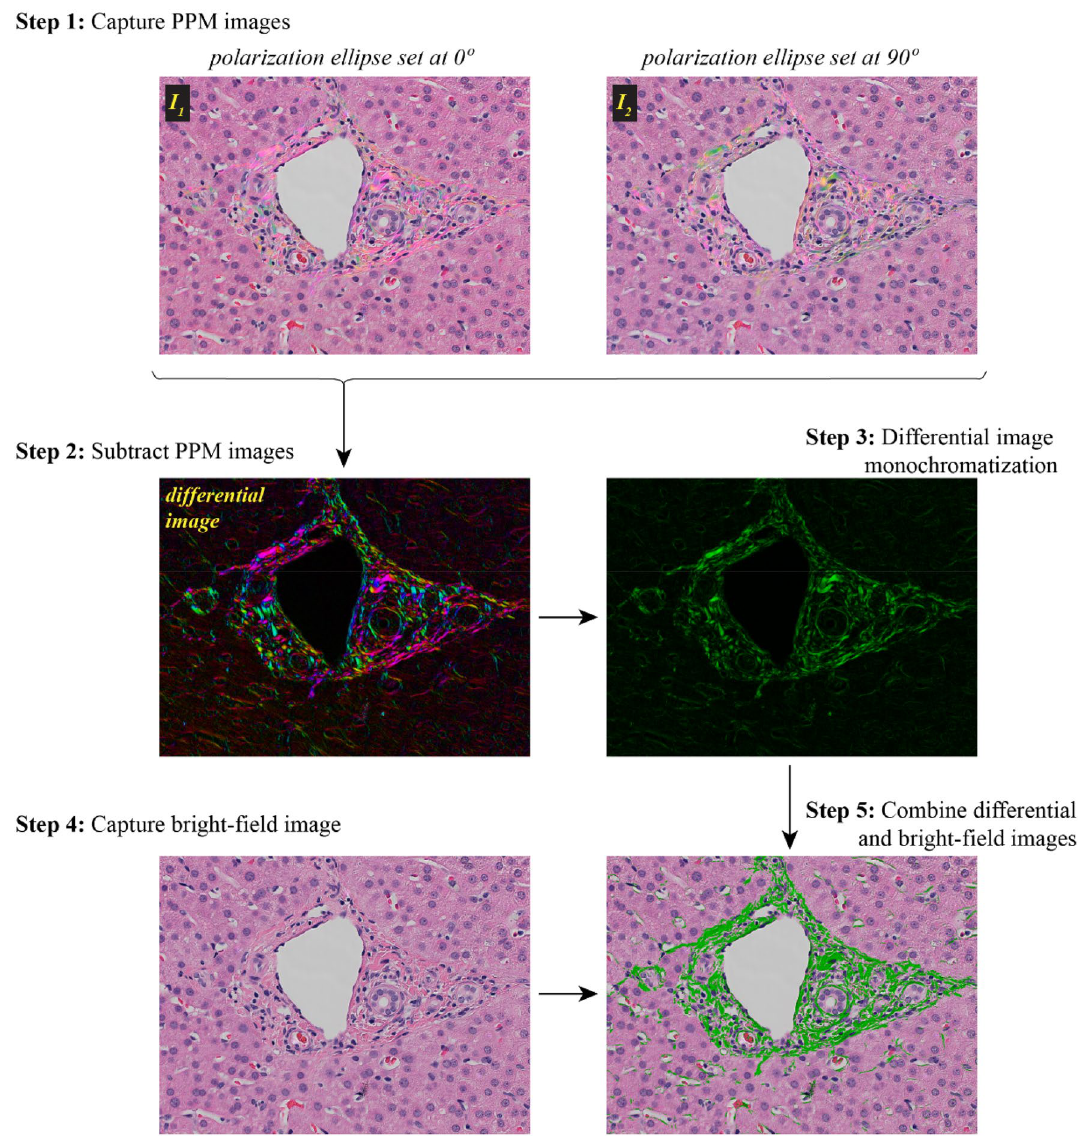
Figure 7. PPM workflow for acquiring birefringence